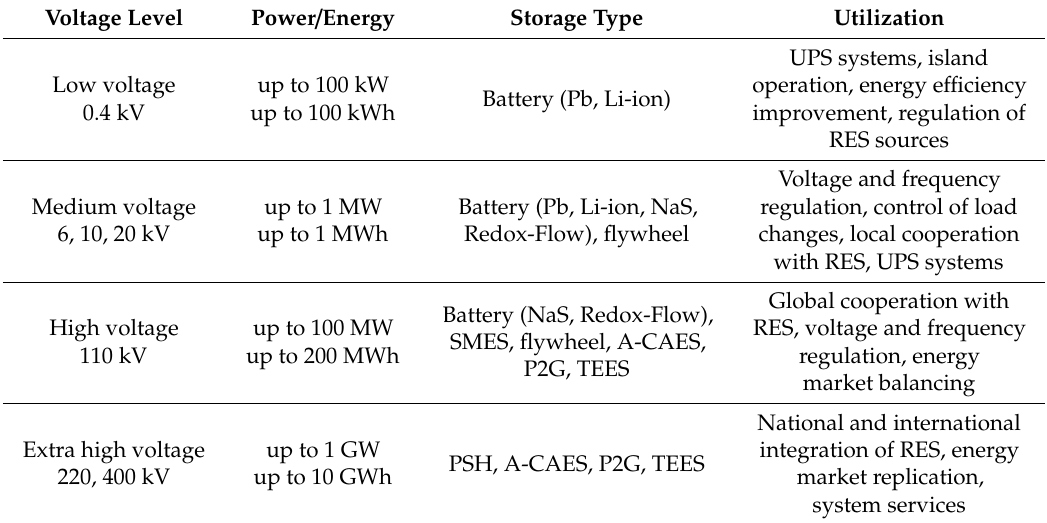
Table 1. Di ff erent types of storage utilization depending on the voltage level